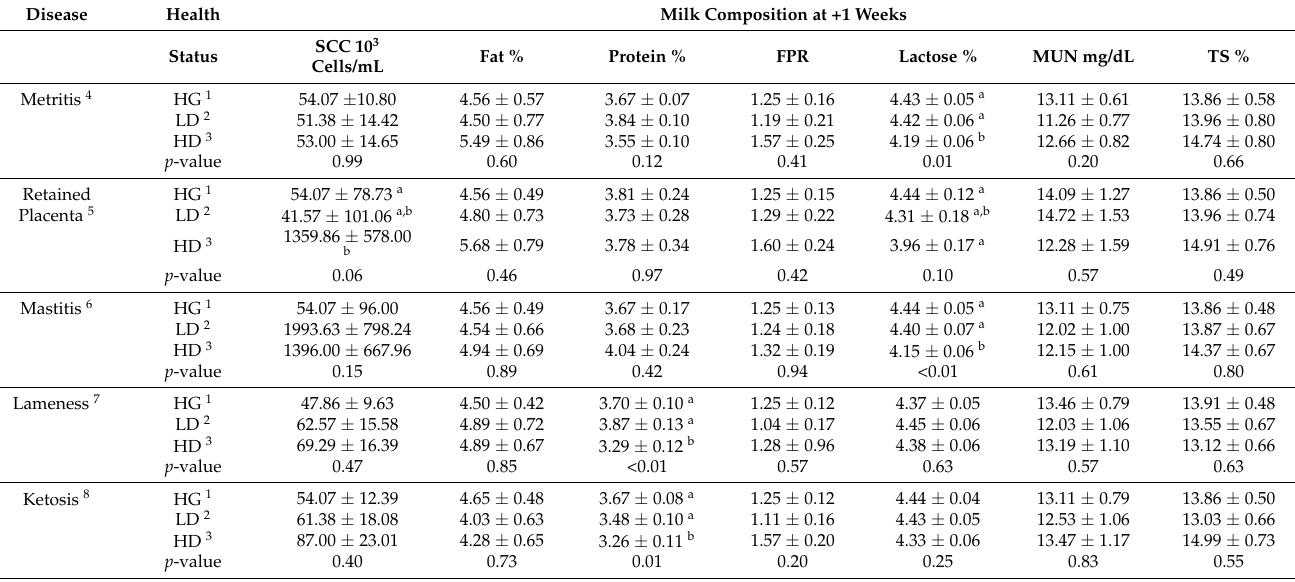
Table 4. Alterations in milk composition (fat, protein, fat:protein ratio, milk urea nitrogen (MUN), total solids (TS), and somatic cell counts (SCC)) at 1 week after parturition in dairy cows diagnosed with post-partum disease.